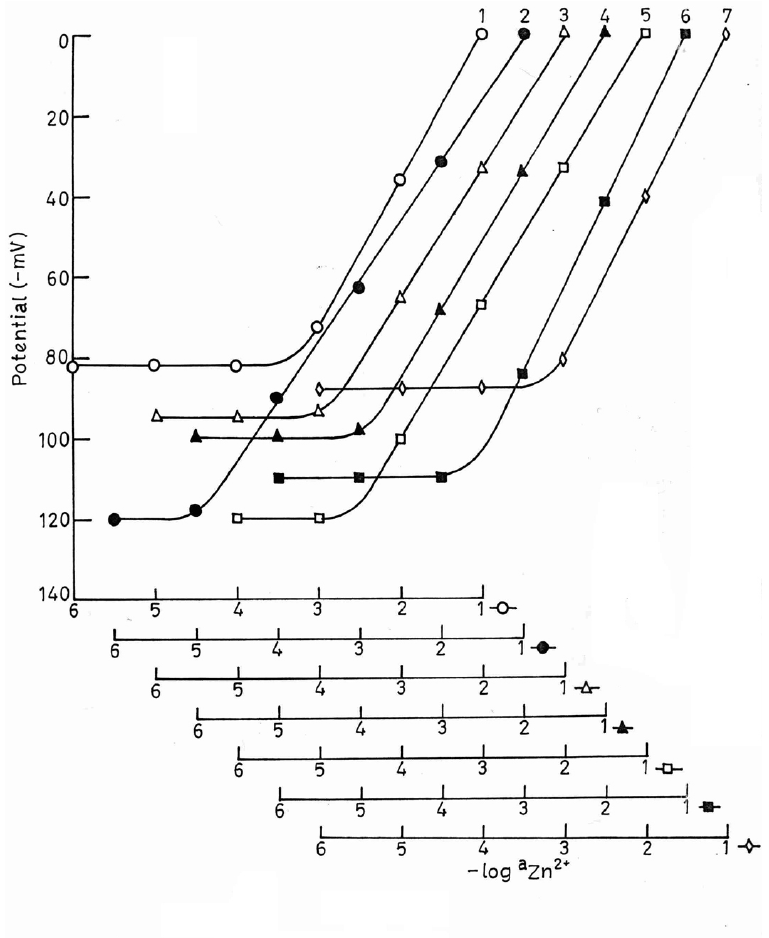
Figure.1 : Variation of potential of PVC based membrane of ( I ) (no.1) without solvent mediator and (nos. 2,3,4,5,6 and 7) with solvent mediators DBBP, DOP, DBP, CN, TEP and TBP, respectively with Zn 2+ concentration. Table 2 : Response characteristics of the PVC based membranes with different amounts of Ionophore